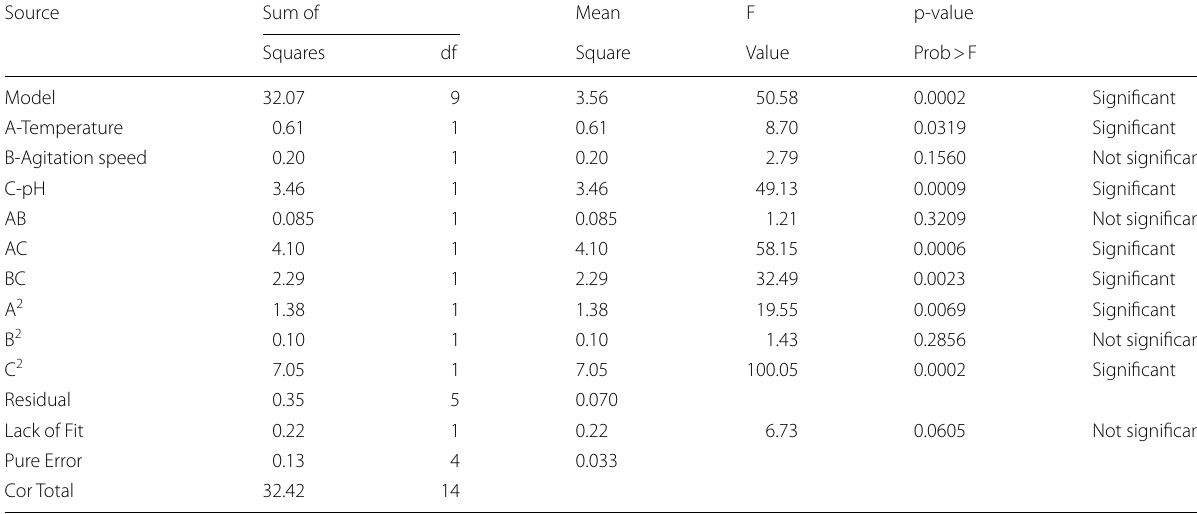
Table 3 Analysis of variance of calculated model for biomass production Source Sum